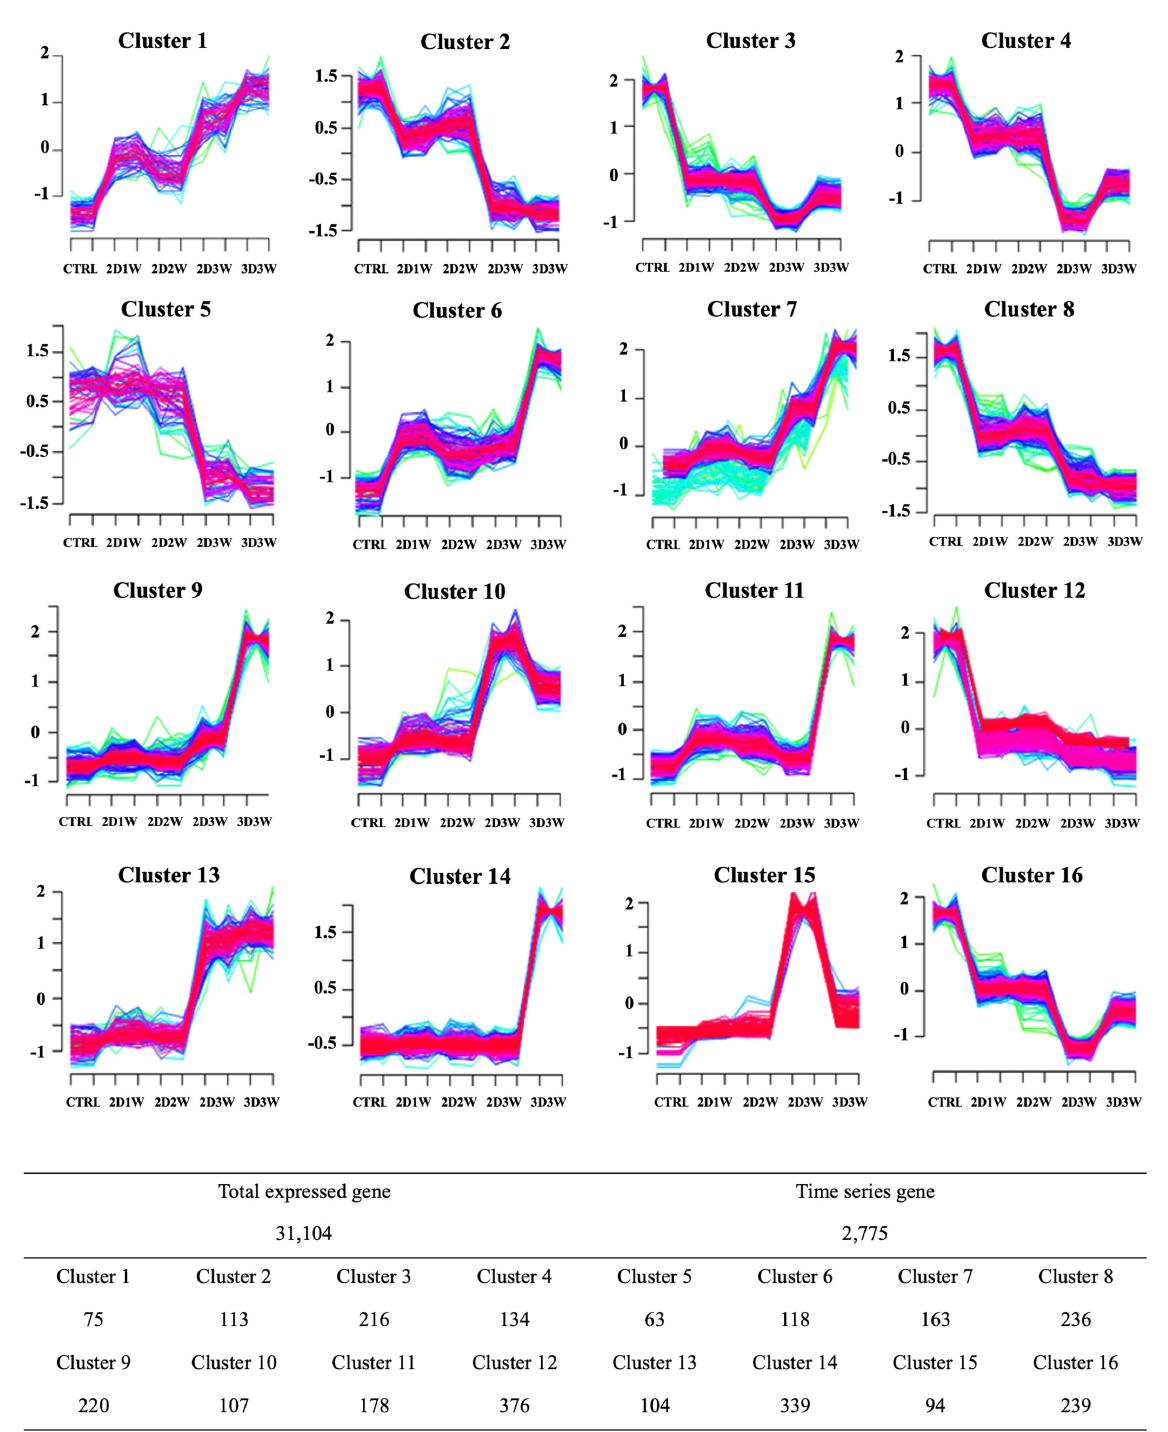
Figure 5. Clustering analysis of time-series genes during osteoblast differentiation using Mfuzz. The x-axis represents each sample. The table below the cluster figures shows the number of genes in each cluster.